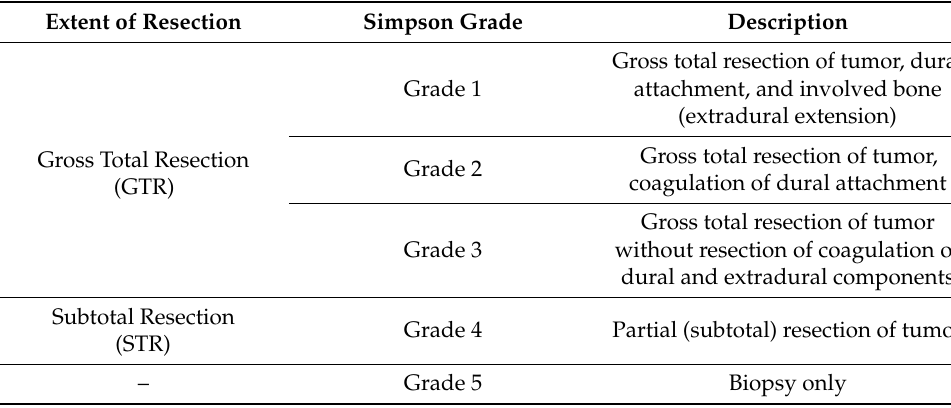
Figure 3. Summary of recommended management of meningiomas. SRS, stereotactic radiosurgery; FRT, fractionated radiotherapy; GTR, gross total resection; STR, subtotal resection. Table 5. Simpson grades of meningioma